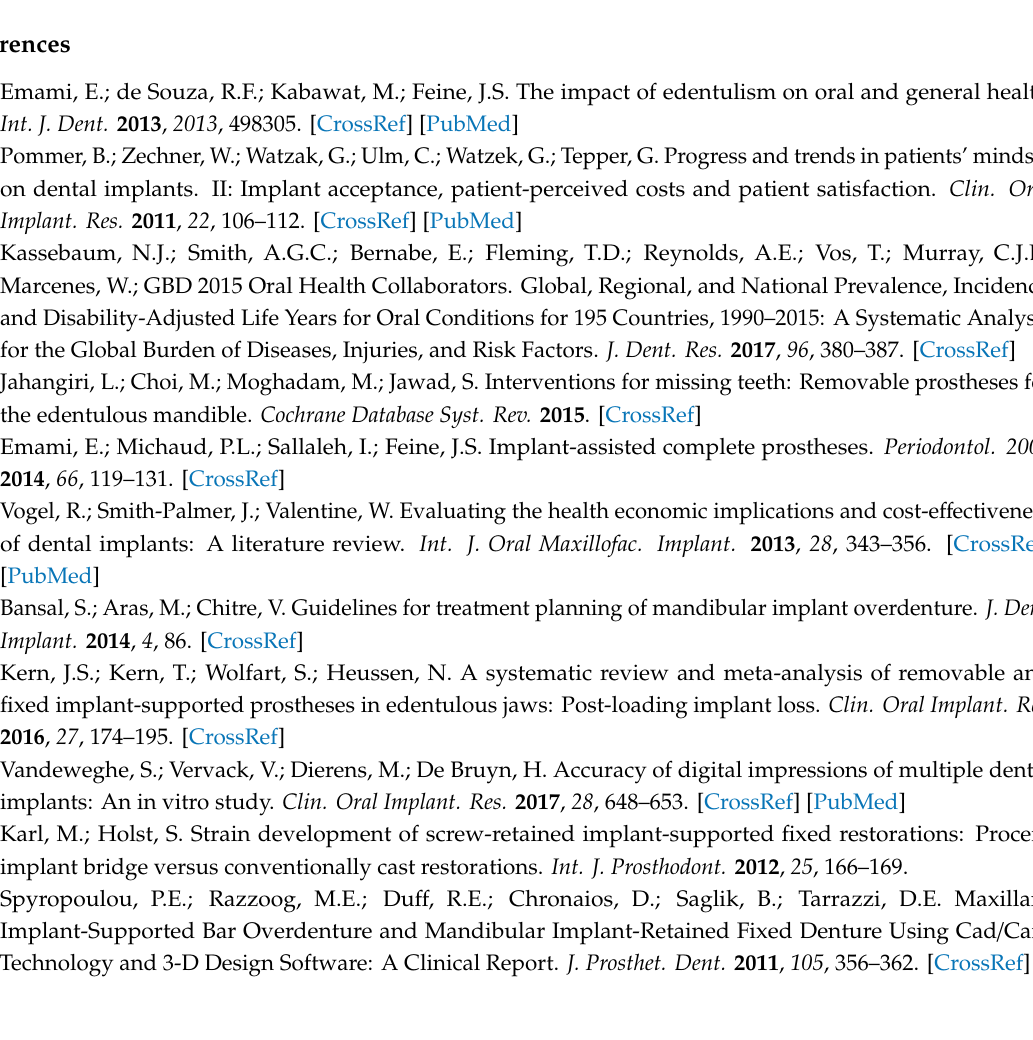
Table S1: Mandibular measurements, Table S2: Amount of bone around the right implant on the buccal and lingual sides at the platform, middle, and apical levels, Table S3: Amount of bone around the middle implant on the buccal and lingual sides at the platform, middle and apical levels, Table S4: Amount of bone around the left implant on the buccal and lingual sides at the platform, middle and apical